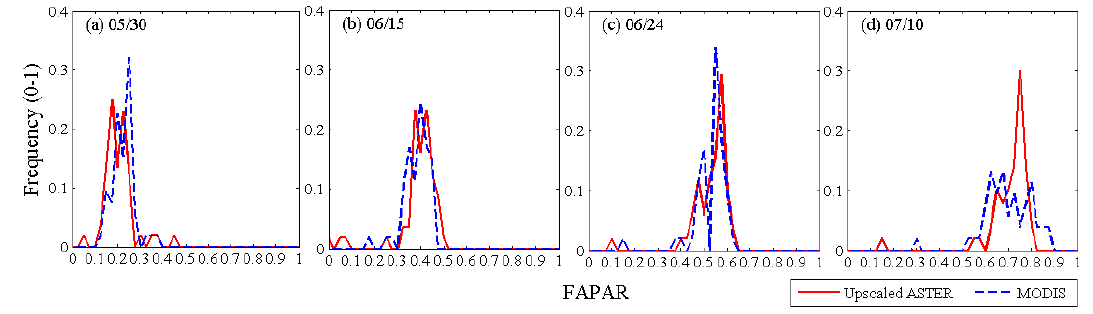
Figure 12. ( a – d ) Histograms of FAPAR values of upscaled ASTER and MODIS product at four dates.